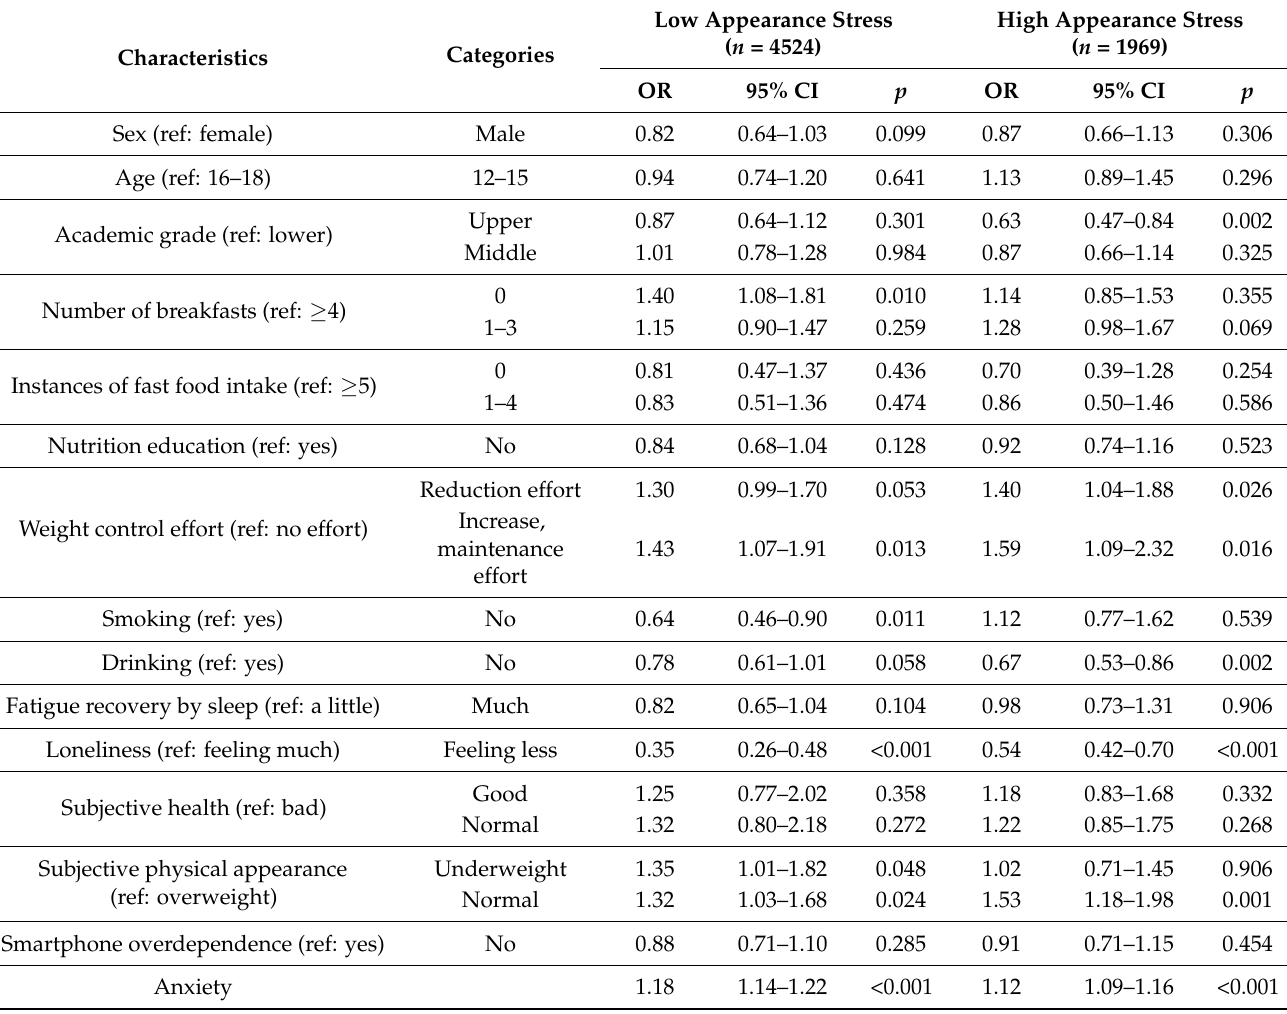
Table 5. Factors related to depression ( n =